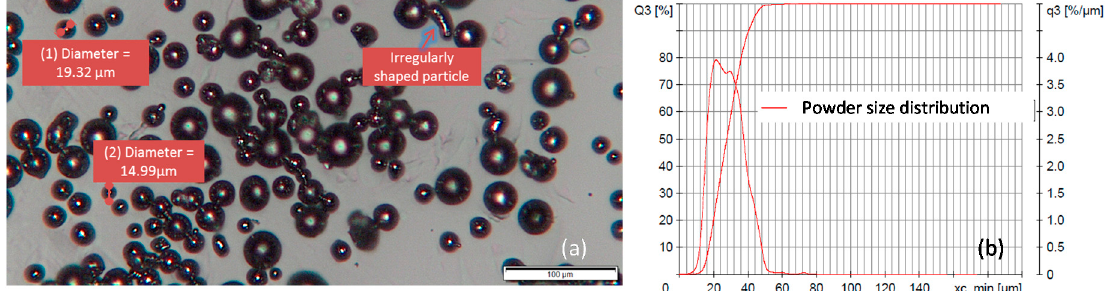
Figure 3. Experimentally determined shape of 16MnCr5 powder ( a ) via optical imaging and particle size distribution ( b ) via Camsizer, provided by FIT AG, Lupburg, Germany.